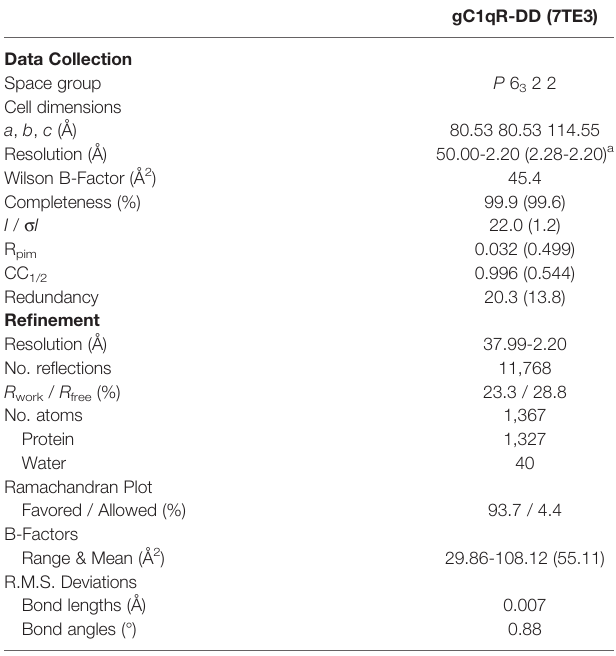
TABLE 1 | X-ray Diffraction Data Collection and Re fi nement